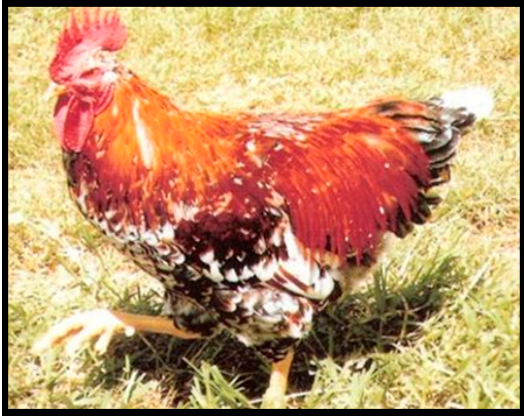
Figure 5. Boschveld chicken breed. Source: [42].